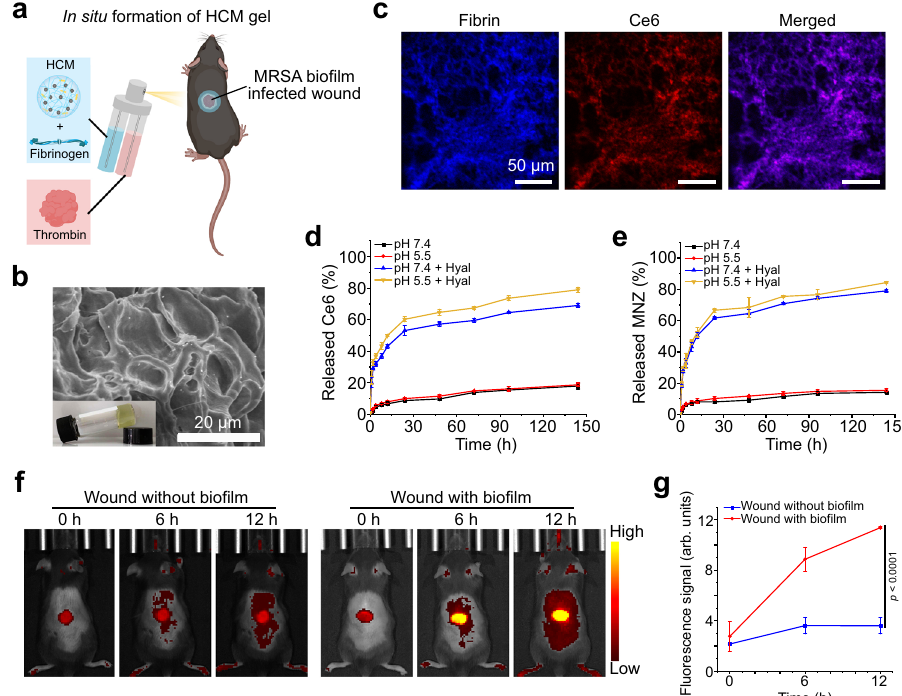
Fig. 7 Preparation and characterization of the HCM gel. a Schematic illustration of the HCM gel in situ formed on bacterial bio fi lm infected wounds. b SEM image of the HCM gel. Inset: photograph of HCM gel. c CLSM images of the HCM gel, in which the fi brinogen was labeled with fl uorescein isothiocyanate (FITC, blue). Cumulative release pro fi le of Ce6 ( d ) and MNZ ( e ) from the HCM gel incubated with or without Hyal under different pH conditions (n = 3 independent samples; mean ± SD). Fluorescence images ( f ) and fl uorescence intensity ( g ) of normal wounds and wounds with MRSA bio fi lm infection in diabetic mice after treatment with HCM gel at different time points ( n = 3 biologically independent animals from f ; mean ± SD). Statistical signi fi cance was analyzed via one-way ANOVA with a Tukey post-hoc test. Three independent experiments were performed and representative results are shown in b and c . Source data are provided as a Source Data fi